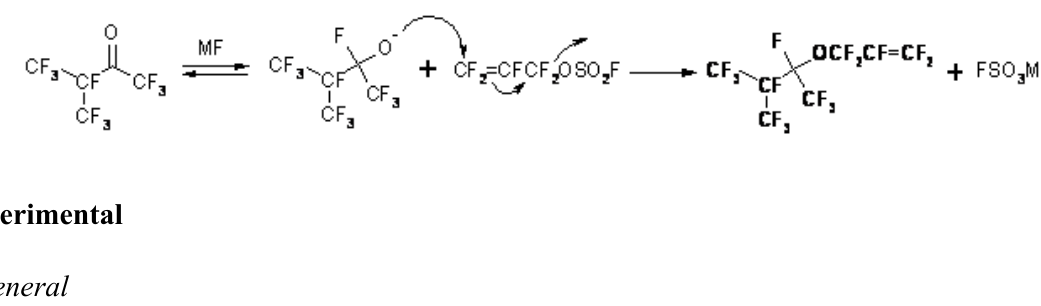
Table 16. Addition of anhydrous H